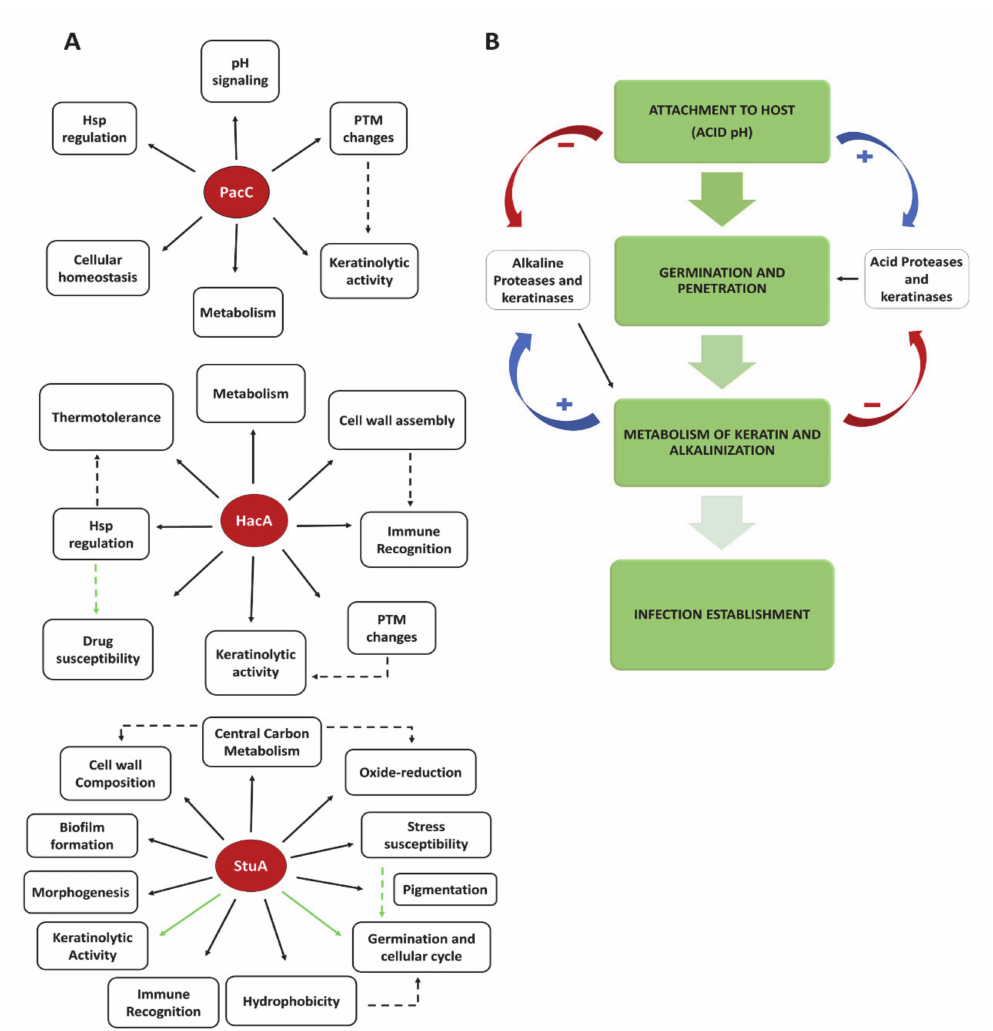
Figure 1. Diagram displaying proteins and enzymes involved in the infectious process: ( A ) The functionality of three transcription factors assessed in dermatophytes and the convergence of their roles during fungus-host interaction and infection outcome. Solid black arrows represent the current knowledge about the regulated processes. Dashed black arrows indicate a correlation between the regulated functions. Solid green arrows depict the possible interwoven paths that control some downstream effects. Dashed green arrows indicate a hypothesized correlation of processes through cross-related paths yet to be elucidated. PTM is related to post-translational modifications; ( B ) stages in the dermatophyte infection process. Positive and negative signals represent induction or repression,